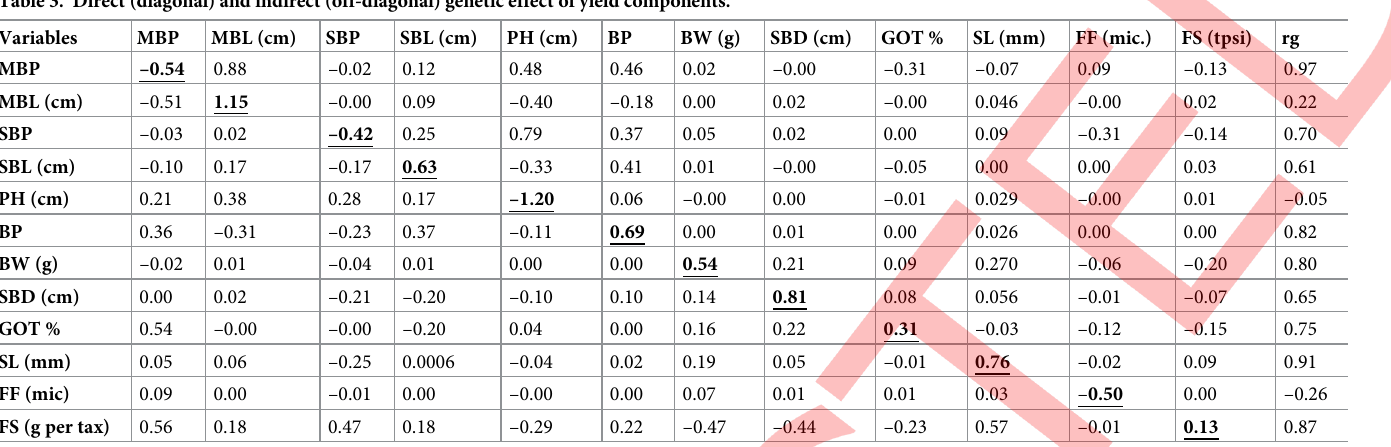
Table 3. Direct (diagonal) and indirect (off-diagonal) genetic effect of yield components.